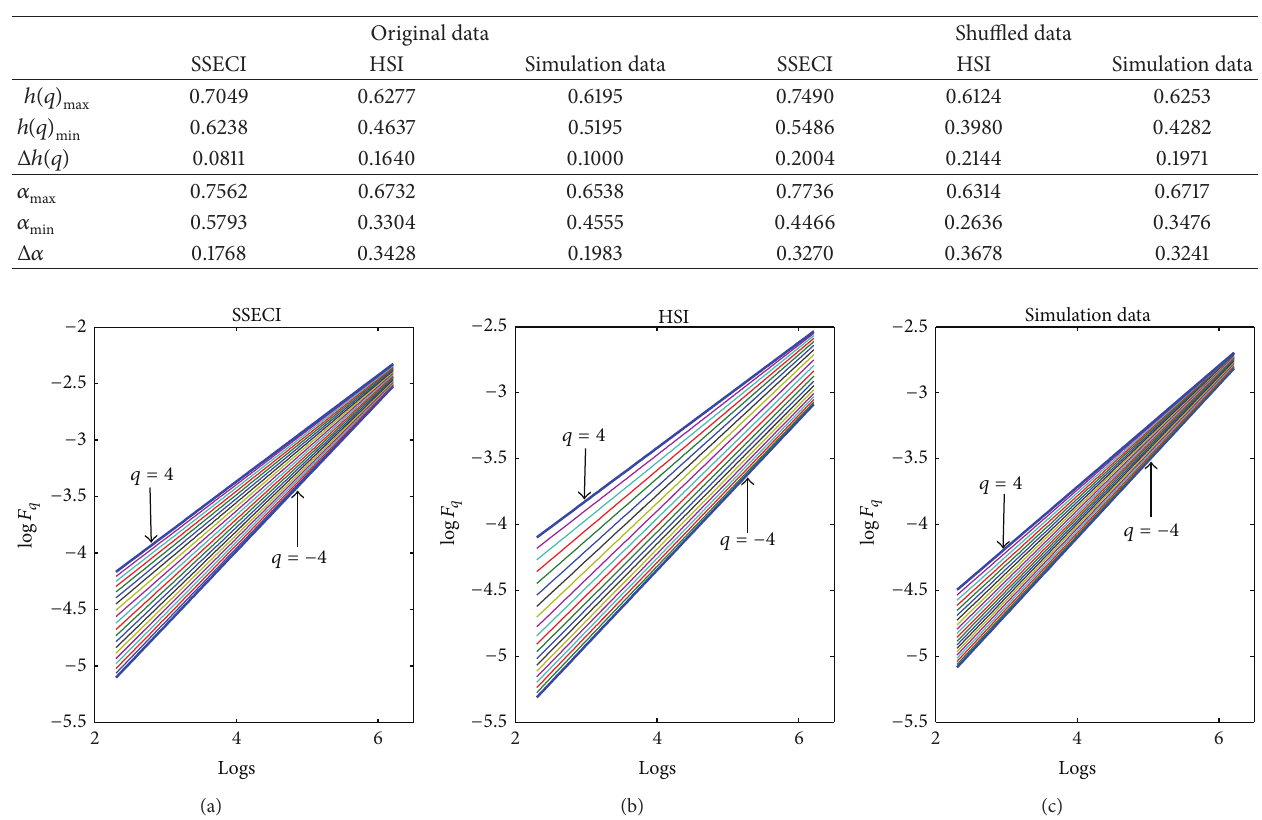
Table 2: Δℎ(𝑞) and Δ𝛼 for SSECI, HSI, simulation data, and their shuffled series.